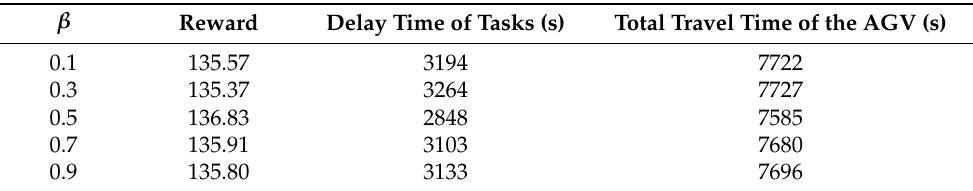
Table 8. Scheduling results of CDA algorithm with different values of β .